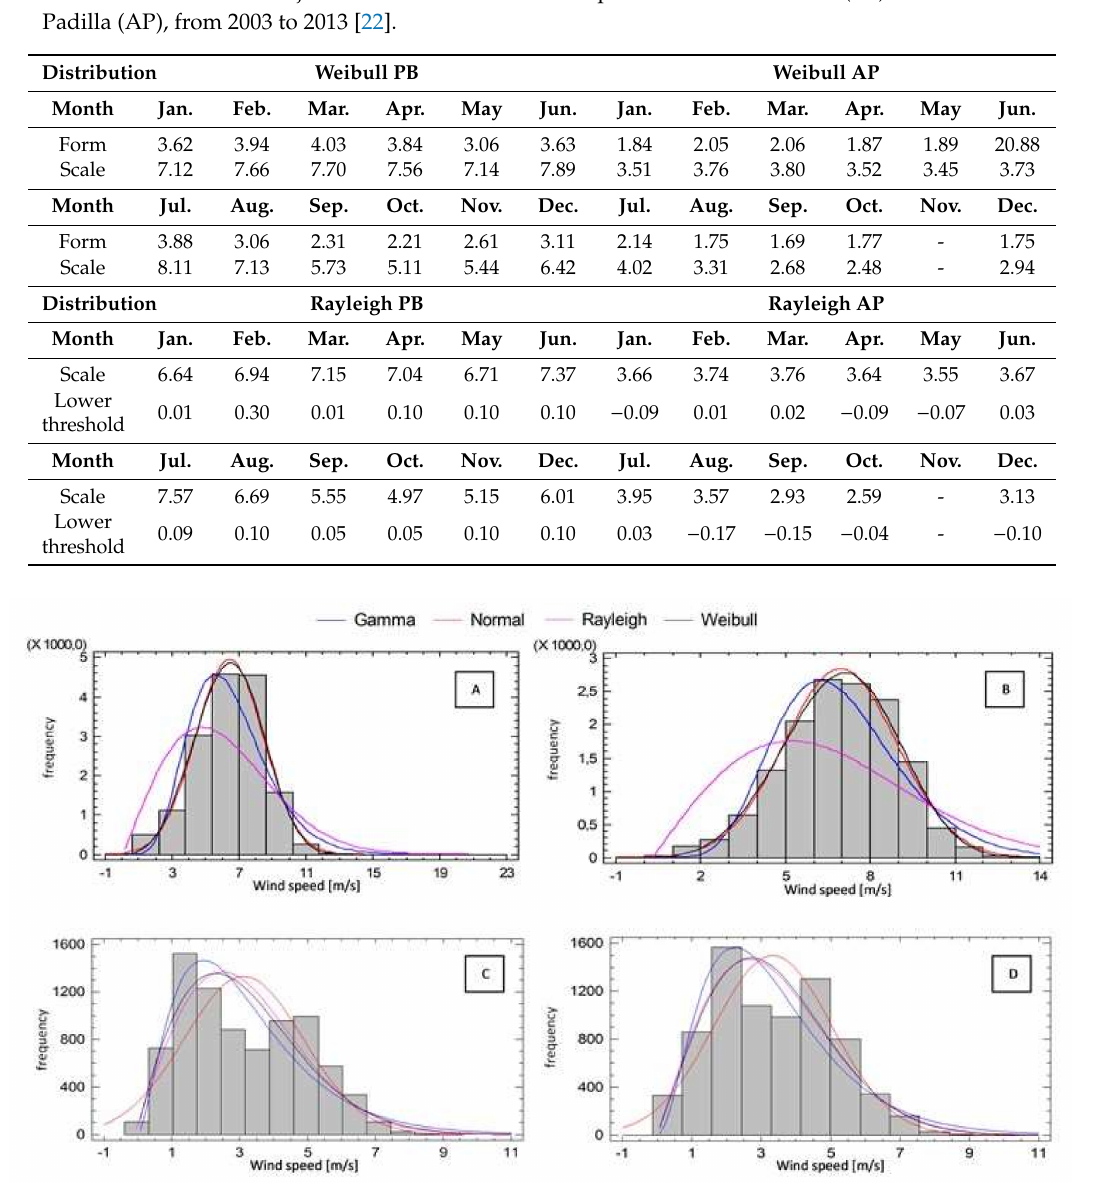
Figure 6. Adjusted frequency distributions of wind speed for Puerto Bolivar, ( A ) January, ( B ) February; and Almirante Padilla, ( C ) January, and ( D )